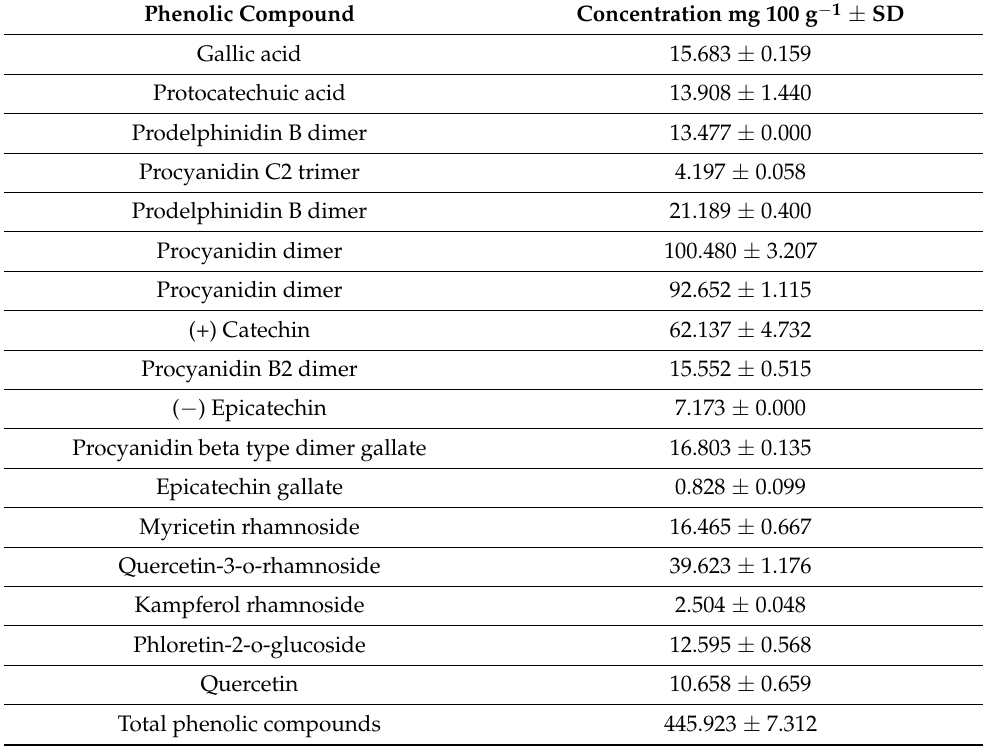
Table 2. Phenolic compound content in hazelnut skin